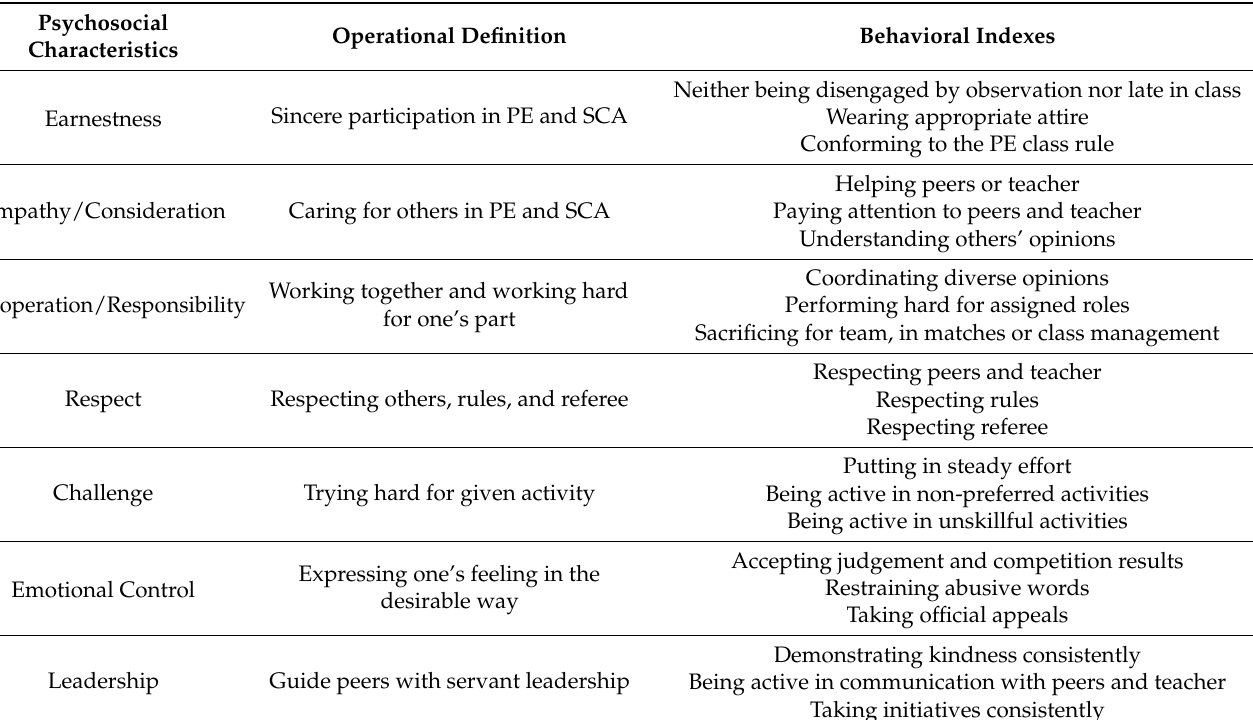
Table 1. Operational Definition of Psychosocial Characteristics.